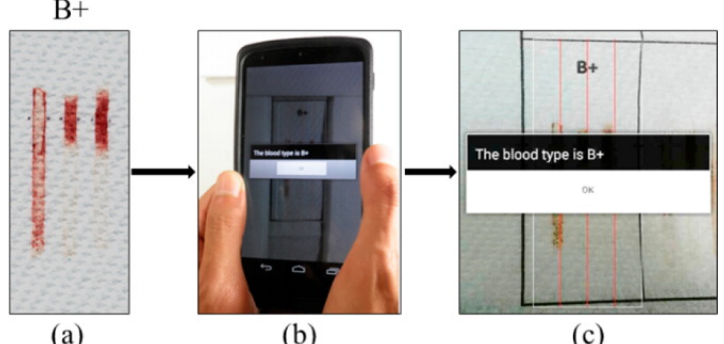
Figure 5. Blood type detection using smartphone. ( a ) Paper sensor with blood-tracks visible in channels. ( b ) Smartphone app developed for interpreting the sensor’s result. ( c ) Detected blood type is displayed as text. Reprint adapted with permission from [67]. Copyright 2018 American Chemical